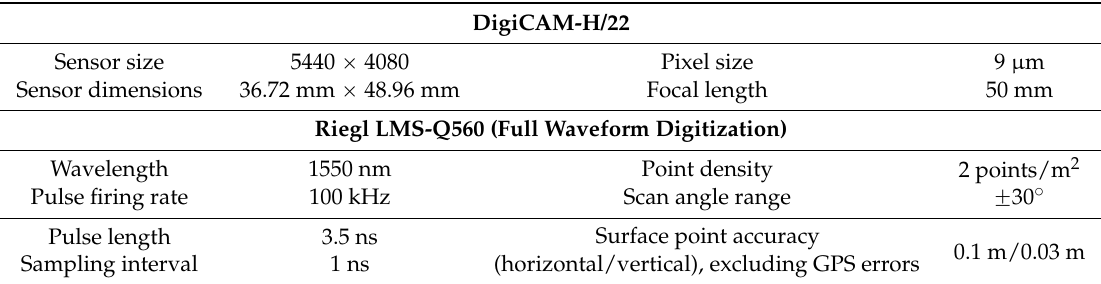
Table 2. Main technical parameters for airborne